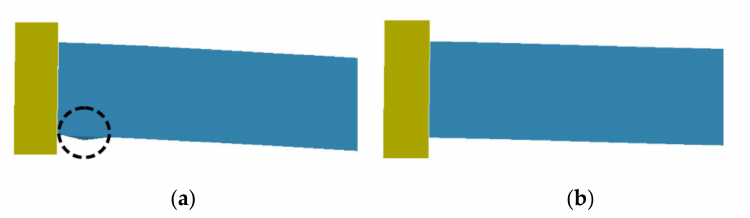
Figure 19. Failure mode of CFDST column with: ( a ) normal strength concrete and ( b ) UHPC [21]. Copyright permission obtained from authors.